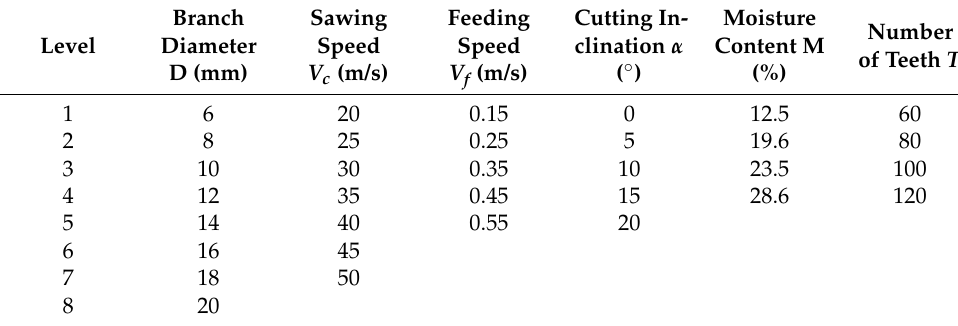
Table 1. Factors and levels of the single-factor